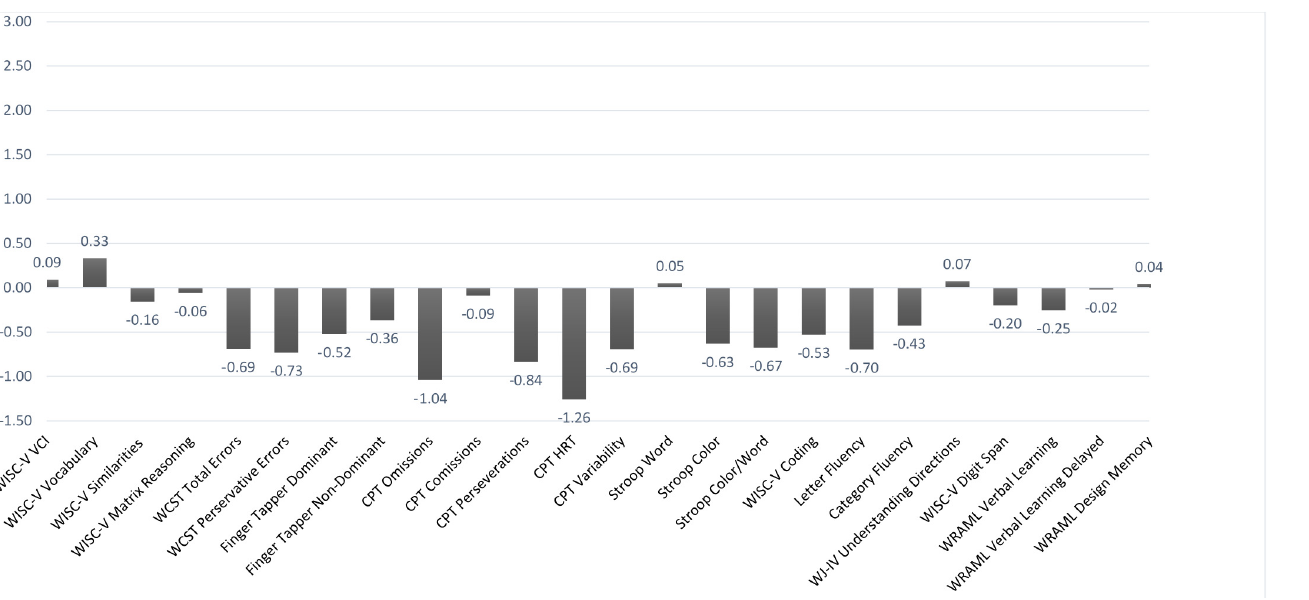
Figure 2. Behavioral Self-Report Baseline Data. n = 17. The y-axis is based on z -scores (M = 0, SD = +/- 1). Higher scores indicate the reporting of greater problem. Revised Child Manifest Anxiety Scale (RCMAS); Child Depression Inventory (CDI); Behavior Rating Inventory of Executive Functioning (BRIEF); Behavior Regulation Index (BRI); Emotion Regulation Index (ERI); Cognitive Regulation Index (CRI); Global Executive Composite (GEC).